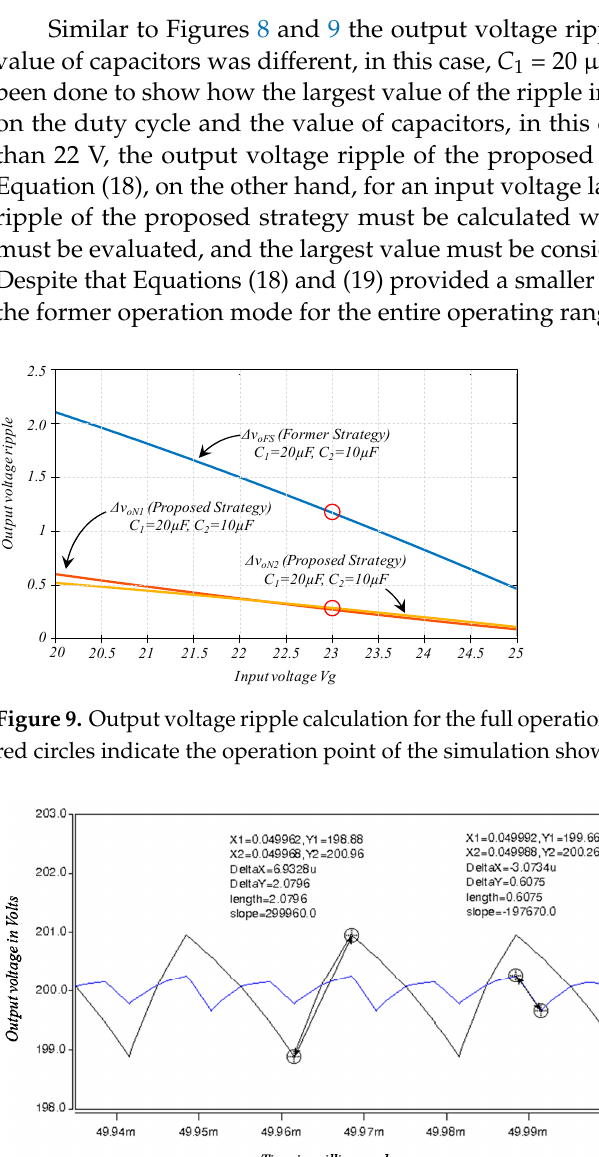
Figure 8. Output voltage ripple calculation for the full operation range with C1 = C2 = 20 µF.